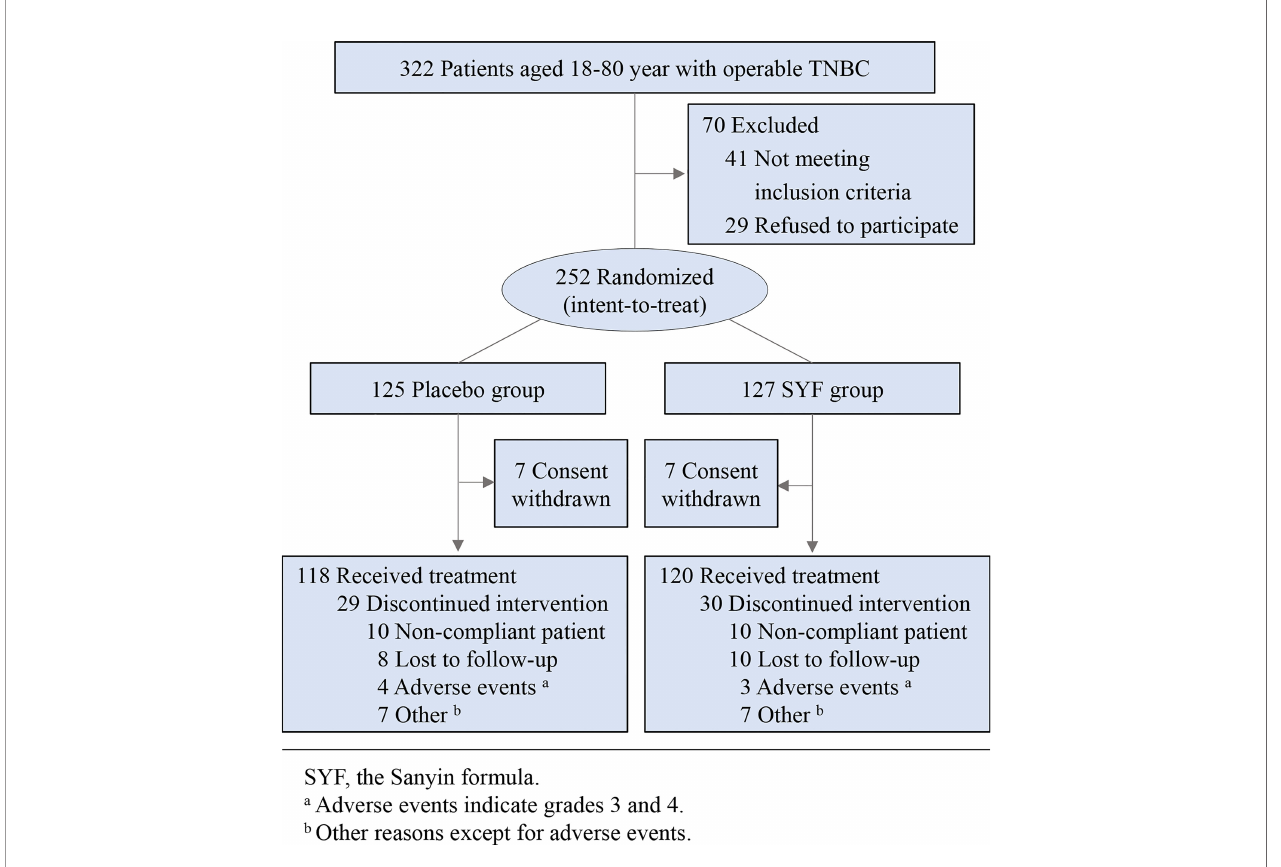
FIGURE 1 | Flow diagram of the